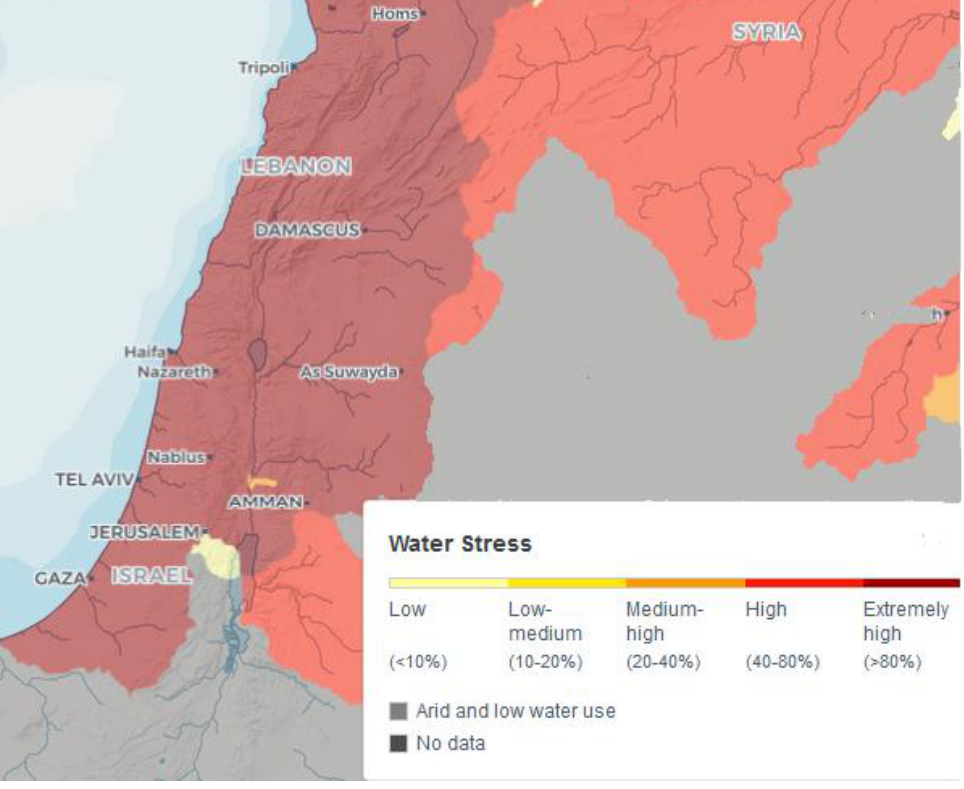
Figure 6. Water Stress (withdrawals relative to available supplies). Source: WRI Aqueduct (2022). https://www.wri.org/applications/aqueduct/water-risk-atlas/ (accessed on 14 February 2022)